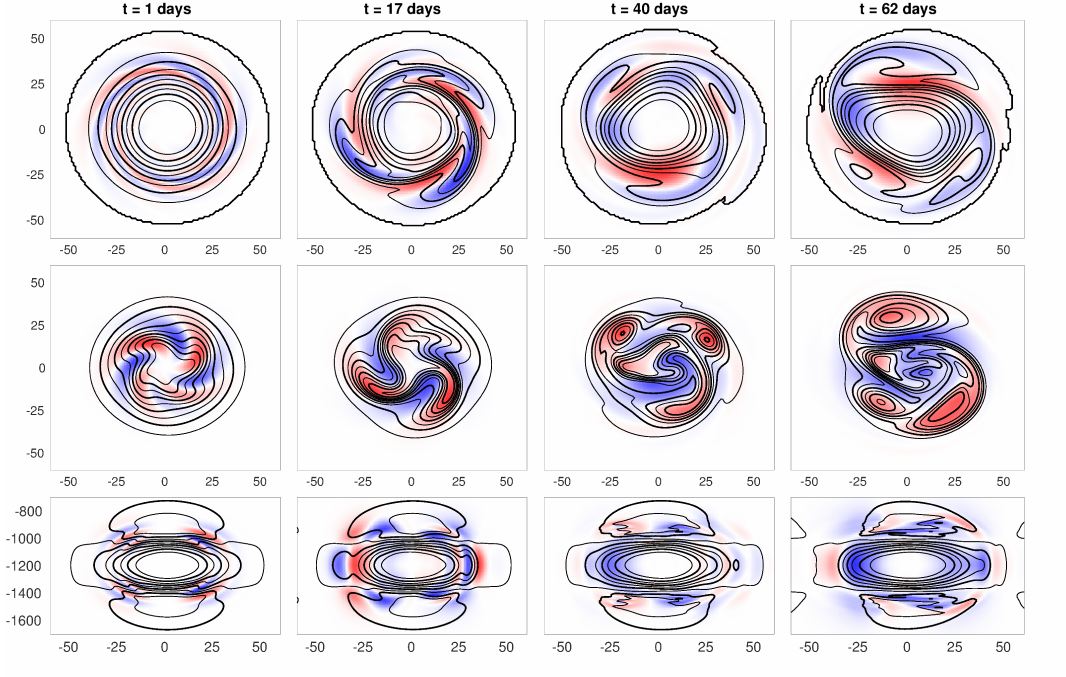
Figure 10. Time evolution of the optimal perturbation for a time interval τ = 17 days in the non-linear QG model. The colour scale shows the PVA perturbation ( q (cid:48) = q − q ) while the black contours show the total PVA q . The top panels show horizontal sections of PVA through the vortex core, the middle panels show horizontal sections of PVA through the vortex lobes and the bottom panels show vertical sections of